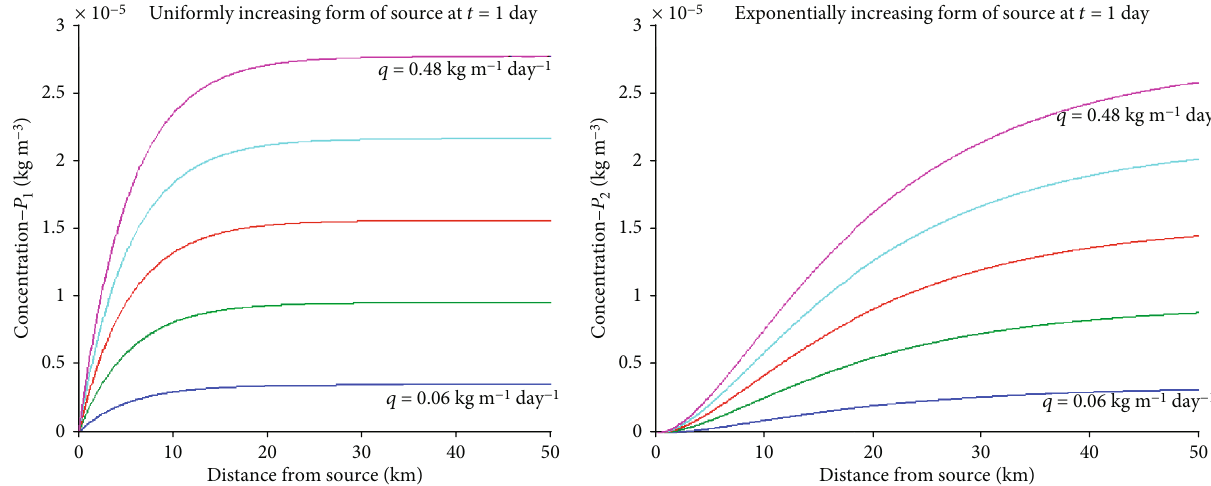
Figure 3: Analysis of pollutant concentrations P